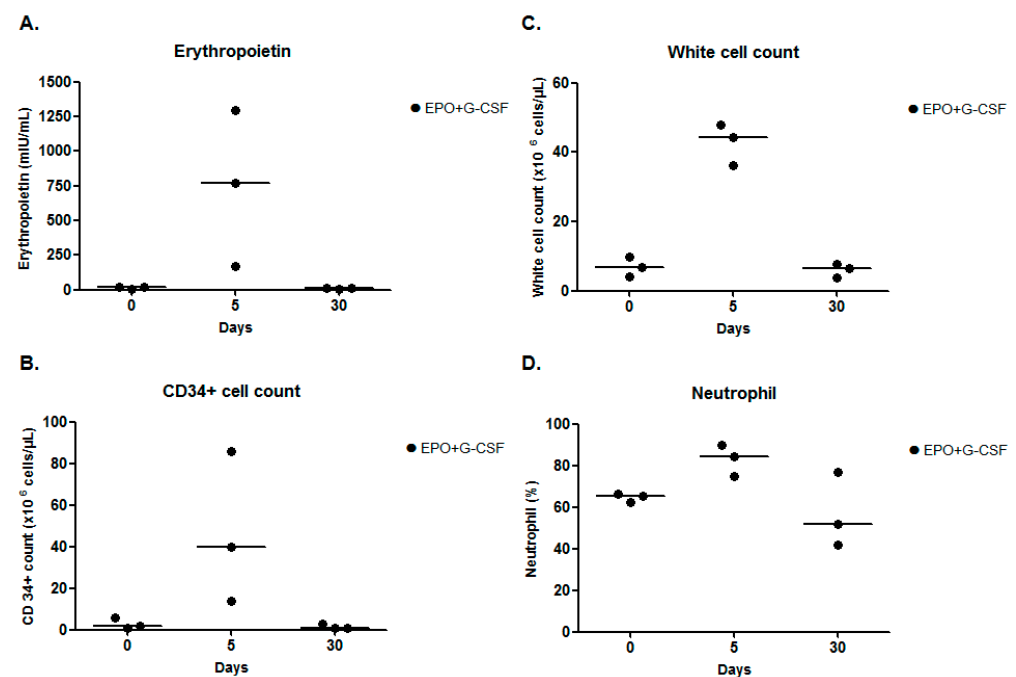
Figure 2. Laboratory measurements for a pilot study. ( A ) Erythropoietin concentration; ( B ) CD34 + cell; ( C ) white cell count; and ( D ) neutrophil on days 0, 5, and 30 of EPO+G-CSF combination therapy. EPO+G-CSF treatment showed peaks on four parameters on day 5. The hematological patterns returned to baseline values on day 30. The line was presented as a median value.